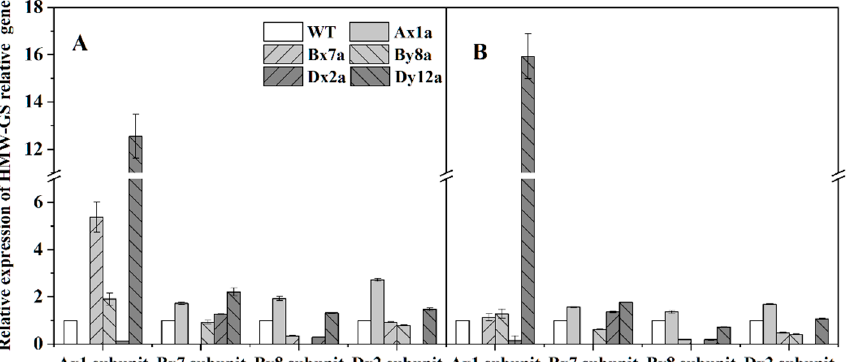
Figure 6. Relative expression levels of HMW-GS-related genes in grains from six wheat lines under N0 ( A ) and N180 ( B ) levels in 2017–2018 wheat growing season.